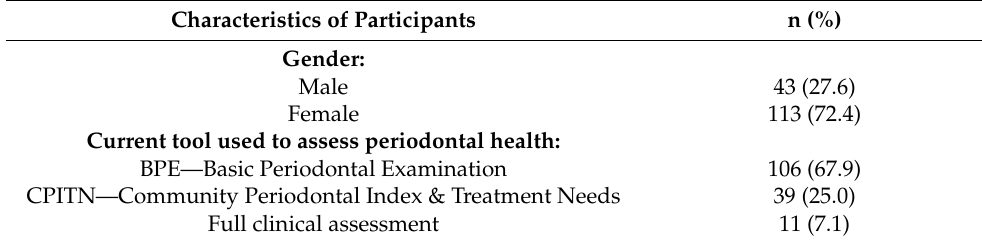
Table 1. Undergraduates’ characteristics, n = 156.